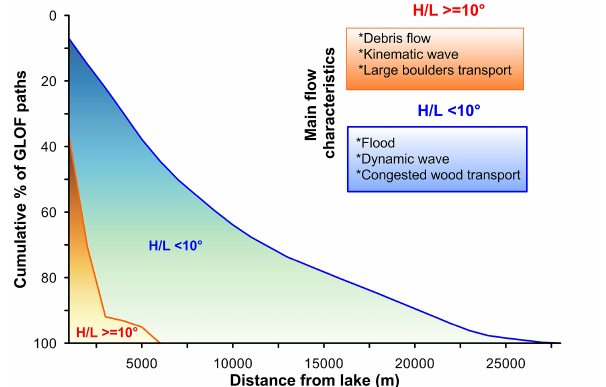
Figure 7. Accumulated percentage of GLOF paths within different angles of reach (H/L). Most path sections with H/L ≥ 10 ◦ (where de- bris flows often occur) are located at distances ≤ 3000m from failed lakes. Sections with H/L ≤ 10 ◦ (89% of the total path lengths) of- ten have diffusive and rapidly attenuating flows. H/L was measured every 10m from 15 failed moraine-dammed lakes in Patagonia.